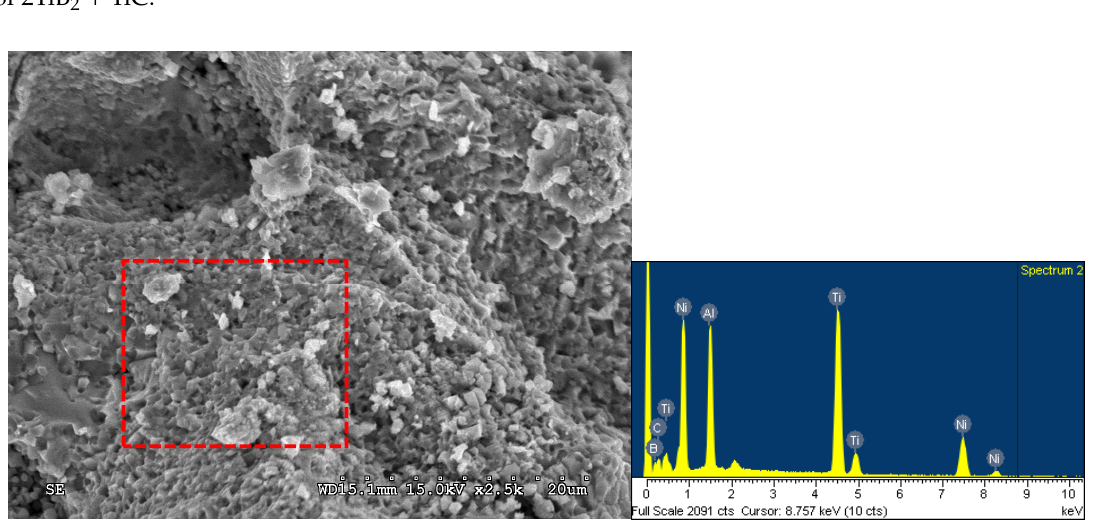
Figure 5. XRD patterns of self-propagating high-temperature synthesis (SHS)-derived products from